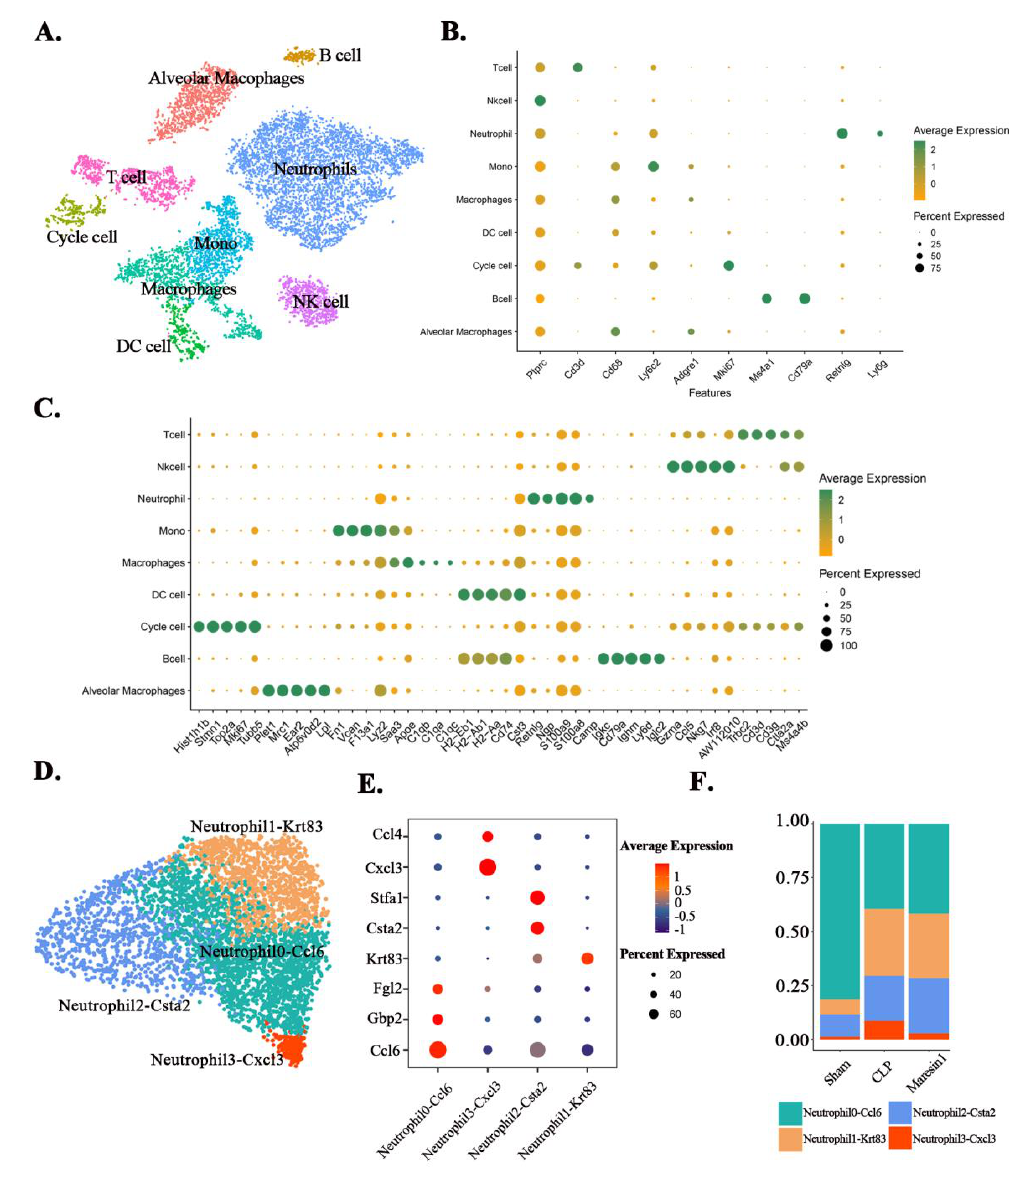
Figure 2. Single-cell sequencing revealed the cellular component of the neutrophil populations. ( A ): The tsne plot of all immune cells (Cd45+), showing a total of 9 distinct immune cell types that were identified. The different cell types are colored as indicated on the label. ( B ): The dot plot of marker genes for different types of immune cells. ( C ): The top5 DEGs for different immune cell clusters. ( D ): The umap plot of the cellular composition of neutrophils in lung tissue. A total of four clusters of neutrophils were identified. ( E ): The dot plot for the principal marker genes of different neutrophil subpopulations. ( F ): The fraction of different neutrophil subpopulations.